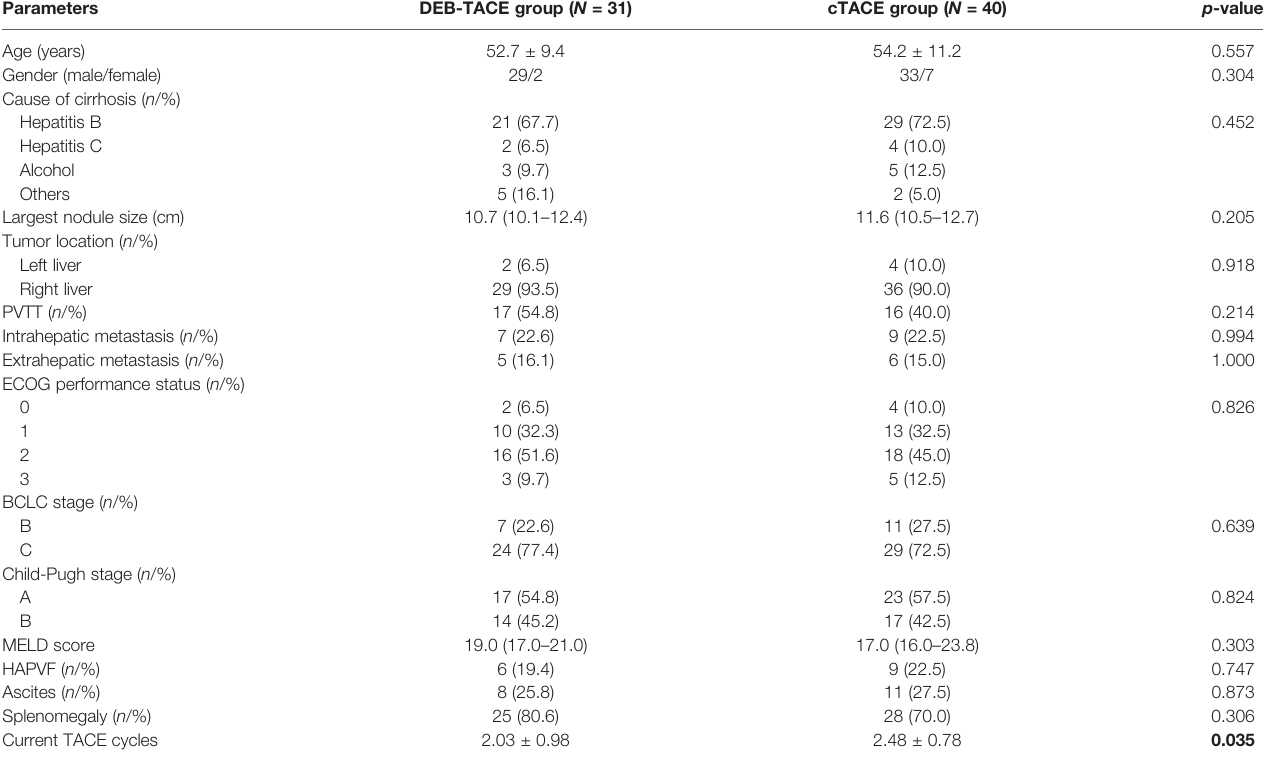
TABLE 1 | Baseline